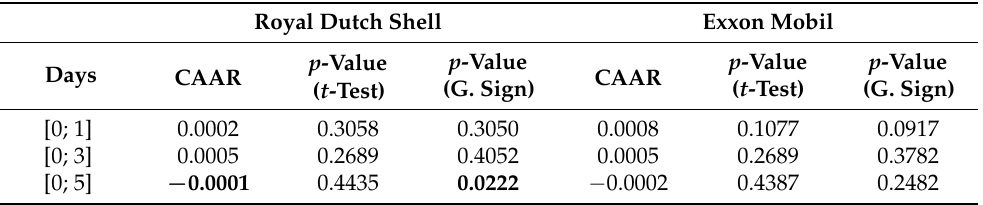
Table 6. Cumulative average abnormal returns Royal Dutch Shell and Exxon Mobil—Induced seismicity in Anadarko Basin ( df =